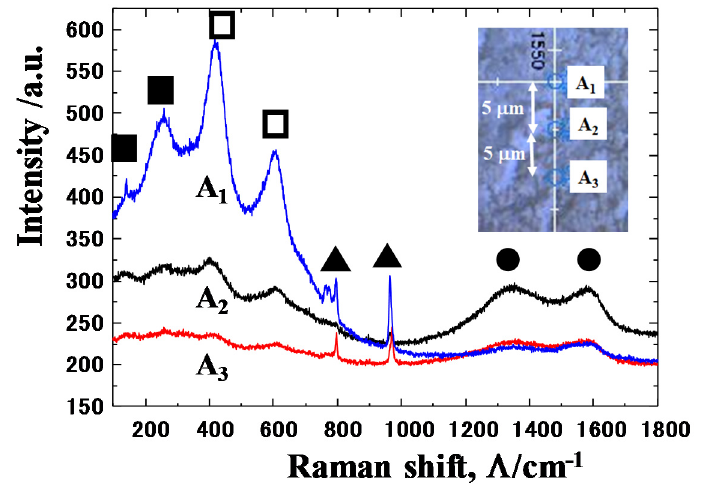
Figure 11. Raman spectrum of the carbon agglomerates, SiC and titanium oxide on the A-region of contact interface between β -SiC coating and titanium work.